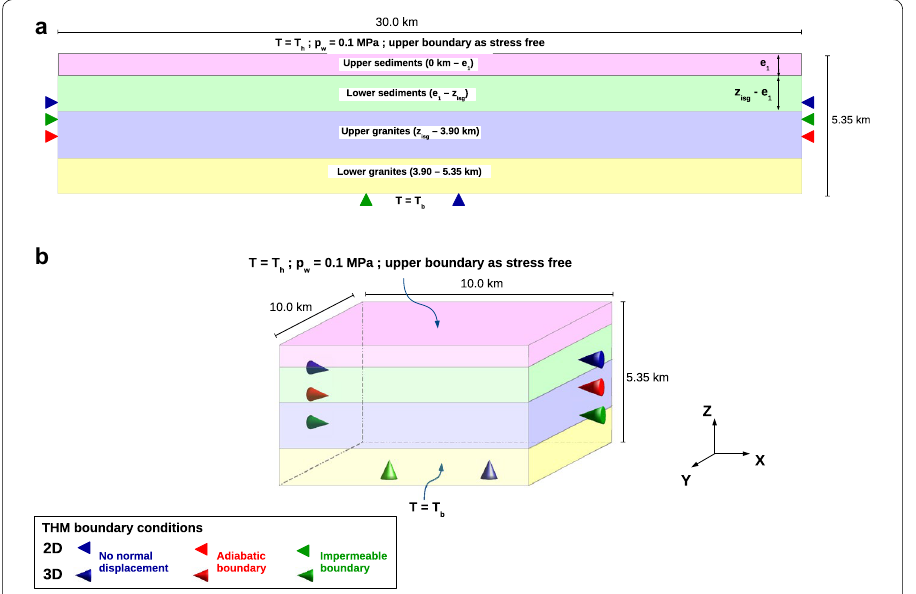
Fig. 4 a 2D vertical cross-section and b 3D model with the boundary conditions used during the simulation. The background colors correspond to idealized layers homogenized at the scale of about 100 m. The thickness of the sediments z isg is about 1.4 km in Soultz. Here, the thickness of the first layer e 1 is evaluated during the back-analysis (Vallier et al. 2019). T b is the bottom temperature set at 208 °C. T h is the surface temperature set at 15